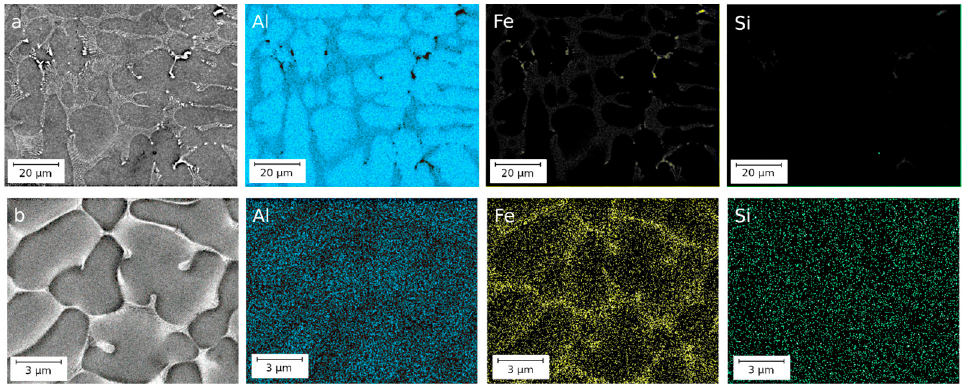
Figure 1. Microstructure of alloys CC ( a ) and EMC ( b ) in their initial states, SEM; ( c ) TEM micro- graph of the EMC sample.